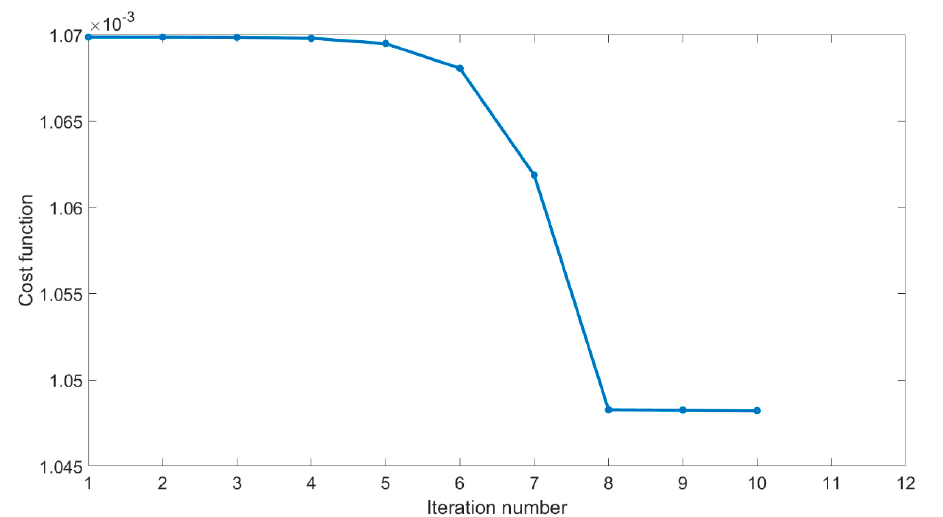
Figure 11. Convergence of the optimization algorithm.